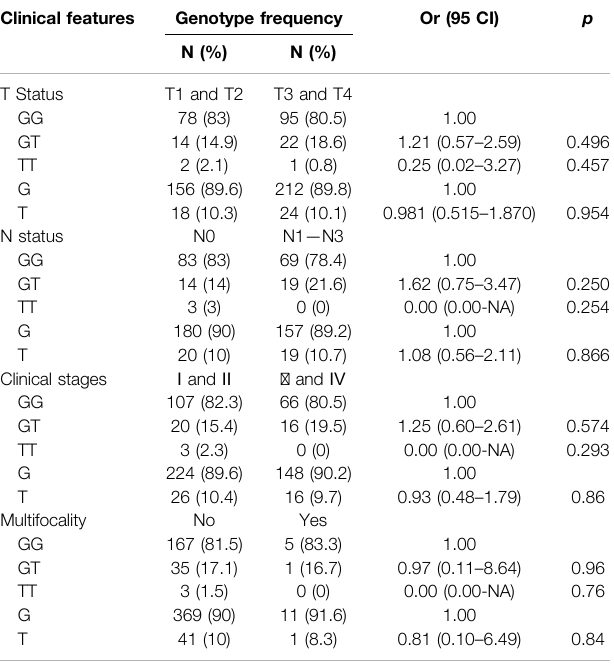
TABLE 2 | Association between the rs4971066 polymorphism and clinical features of GC patients Clinical